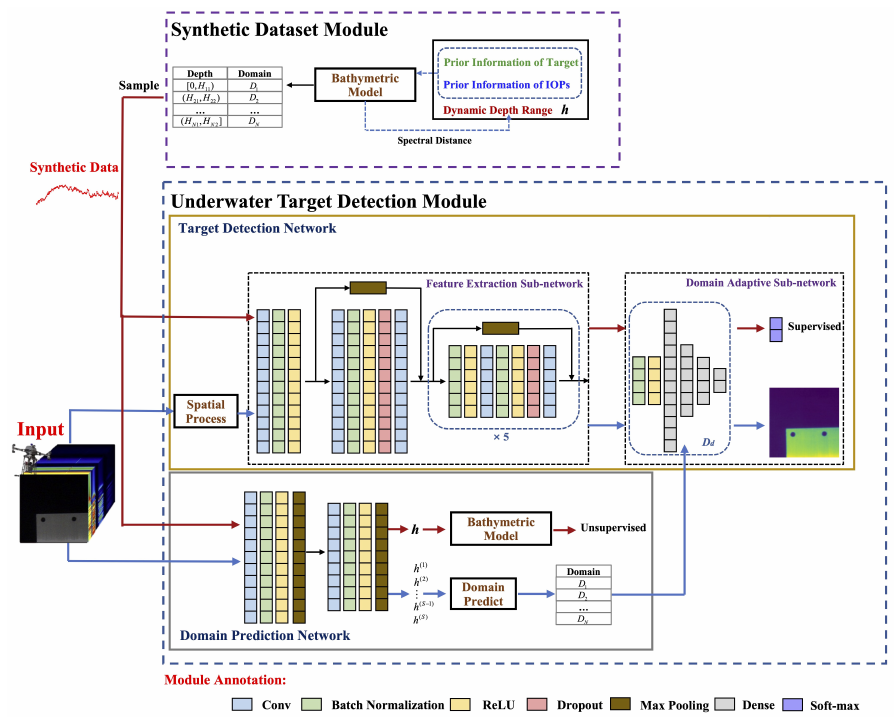
Figure 8. The general framework of our proposed